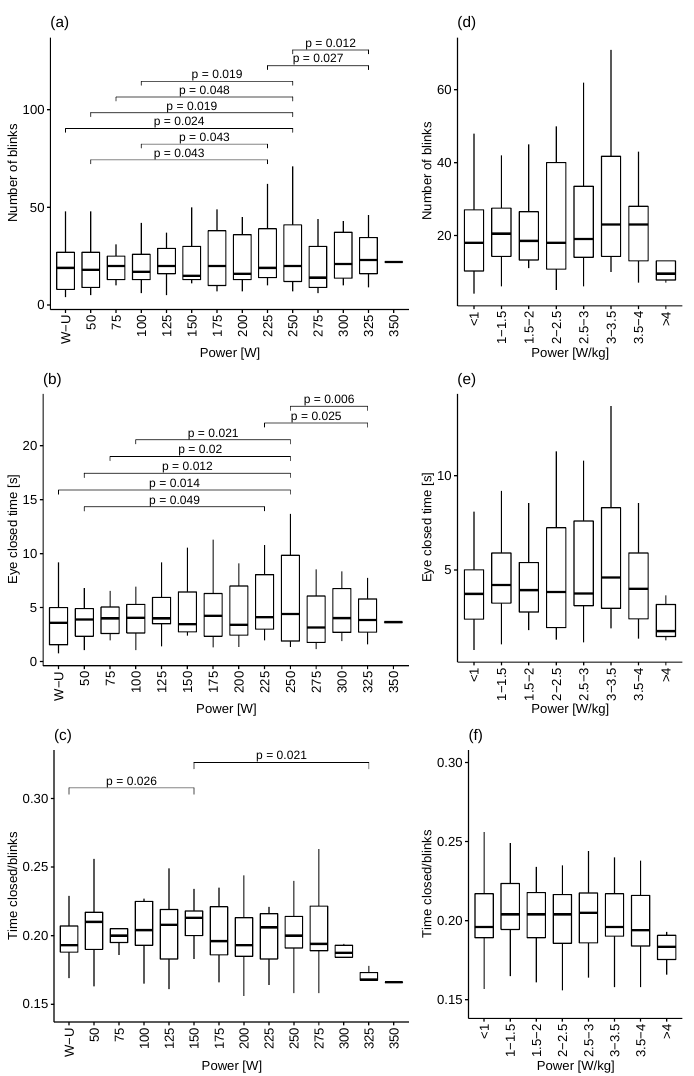
Figure 5. Number of blinks, eye closed time and time